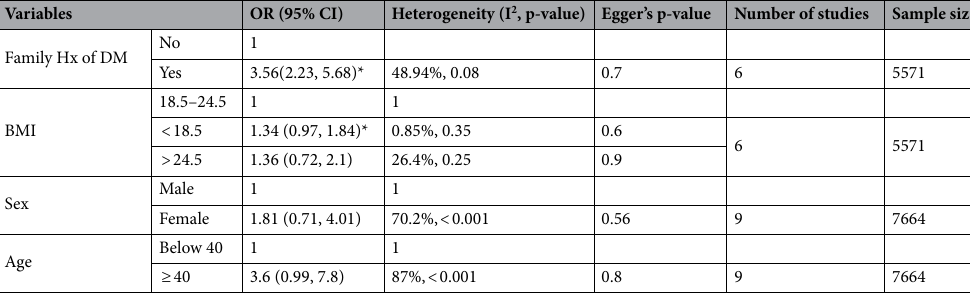
Table 4. Summary of the pooled effects of factors associated with undiagnosed DM among adults in Ethiopia, 2021.